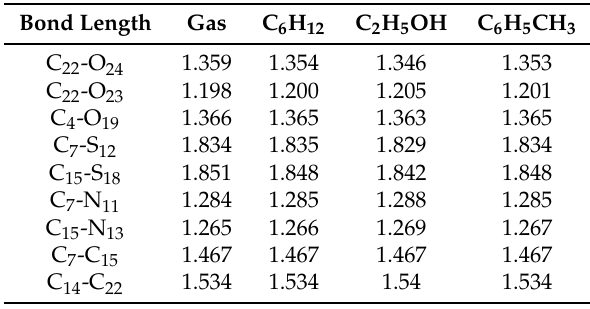
Table 2. Different bond lengths (Å) of native D-luciferin molecule both in gas and solvent phase. Bond Length